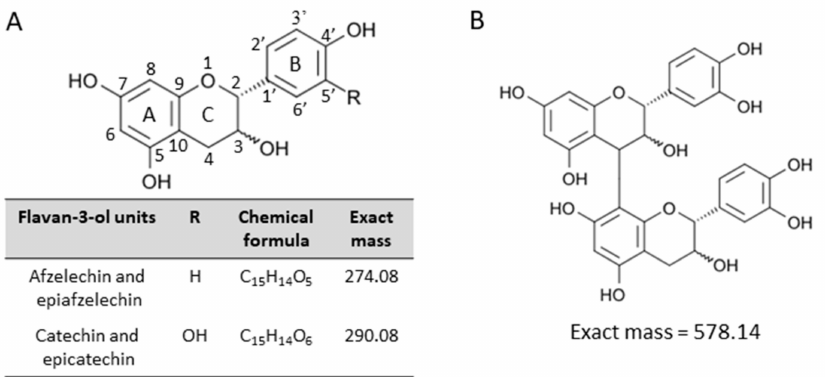
Figure 1. Structures of the flavan-3-ol species analyzed in this study. Structures of ( A ) flavan-3-ol units of proanthocyanidin species, ( B ) B-type procyanidin, (epi)catechin dimer. (Epi)catechin represents either catechin or